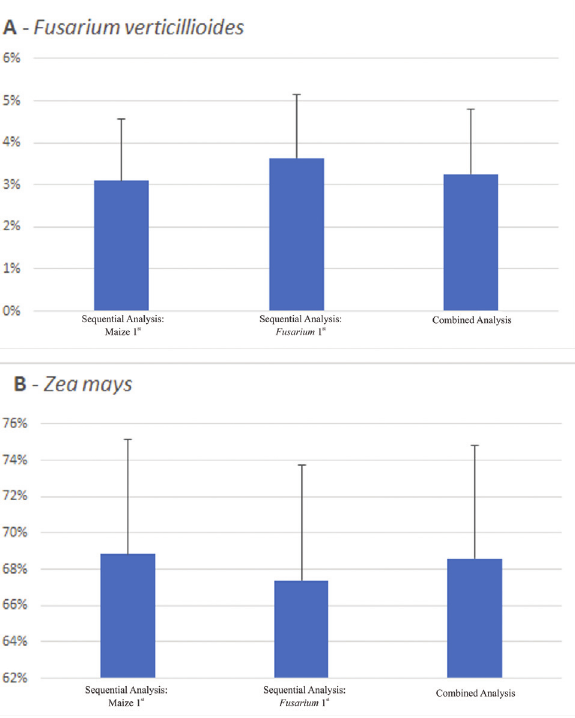
Figure 3 - Percentage of reads mapped to (A) Fusarium verticillioides or (B) Zea mays depending on the methodology used in the Zea mays –Fusarium verticillioides experiment. Bars indicate twice the Standard